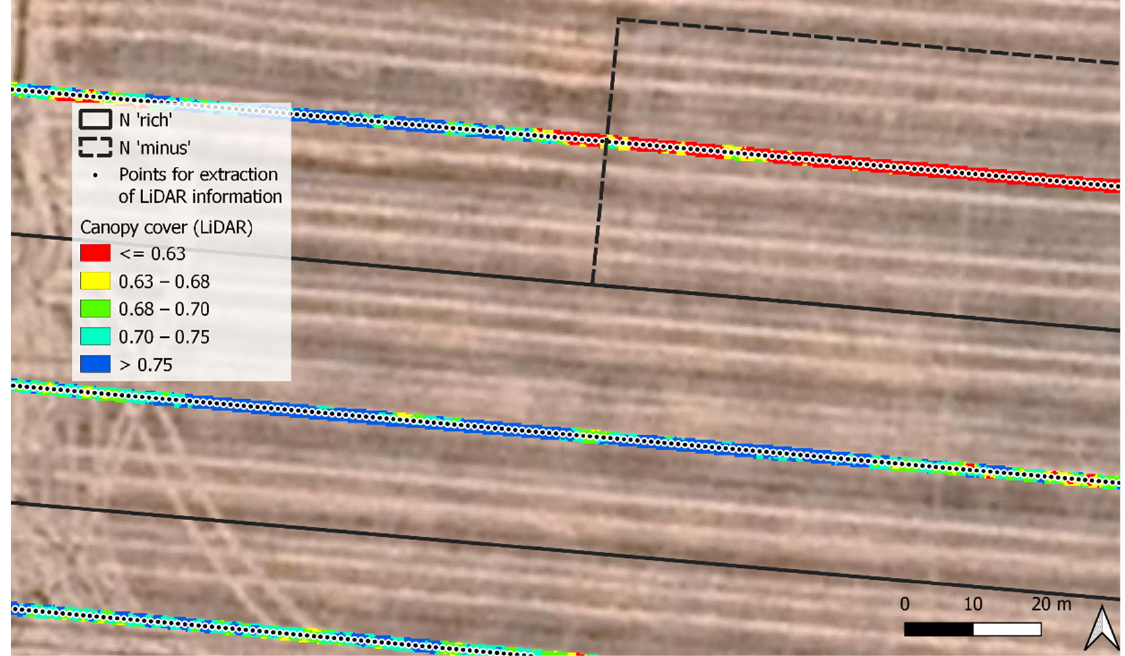
Figure 4. Detail of LiDAR ‘raster’ information (coloured pixel strips) and overlaying virtual points for the extraction of LiDAR information; colour classes are divided by quantiles (i.e., 20th percentiles).